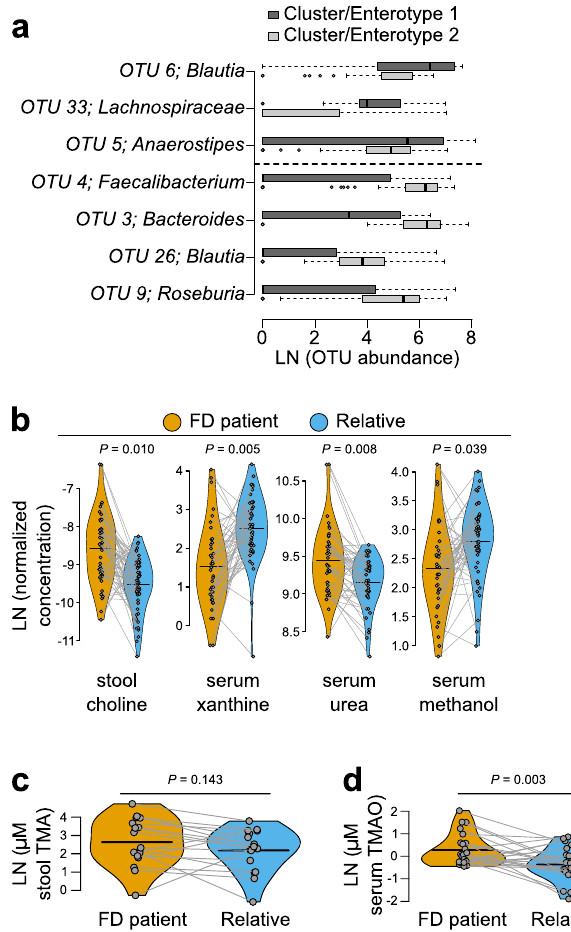
Fig. 2 | Microbiome OTU and metabolite differences in FD. a OTUs responsible for observed partition around medoids (PAM) clusters/enterotypes identi fi ed by random forest analysis. OTUs de fi ning cluster/enterotype 1 are shown above the dotted line. OTUs de fi ning cluster/enterotype 2 are shown below the dotted line (centrality line=median, boxes=IQR, whiskers=1.5 times IQR, dots beyond whis- kers=outliers). b Metabolites showing signi fi cantly different abundances in FD patients compared to relatives (line=mean). c Targeted analyses of TMA in stool (line=mean). d Targeted analysis of TMAO in serum (line=mean). n= a , 48 patients, 51 relatives; b , stool, 54 patient, 58 relatives; serum, 49 patients, 53 rela- tives; c , d , 24 patient-relative pairs. Random forest analysis ( a ); Natural log (LN) transformed metabolite concentration, permutational paired t-testing (two-sided) with FDR correction ( b , choline, mean t-statistic=0.1485, df=33, mean difference between patient-relative pairs=0.9860, mean 95% con fi dence interval of differ- ence between patient-relative pairs=0.5281 to 1.4440; xanthine, mean t-statistic= 2.9527, df=33, mean difference between patient-relative pairs= − 0.9591, mean 95% con fi dence interval of difference between patient-relative pairs= − 1.4051 to − 0.5130; urea, mean t-statistic=0.9269, df=33, mean difference between patient- relativepairs=0.7281,mean95%con fi denceintervalofdifferencebetweenpatient- relative pairs=0.3527 to 1.1036; methanol, meant-statistic= − 1.5497, df=33, mean difference between patient-relative pairs= − 0.7295, mean 95% con fi dence interval of difference between patient-relative pairs= − 1.1875 to − 0.2716); Paired t-testing, two-sided) ( c , TMA, t-statistic=1.5423, df=16, difference between patient-relative pairs=0.4499, 95% con fi dence interval of difference between patient-relative pairs= − 0.1685 to 1.0682; d , TMAO, t-statistic=3.3197, df=23, difference between patient-relative pairs=0.6418, 95% con fi dence interval of difference between patient-relative pairs=0.2419 to